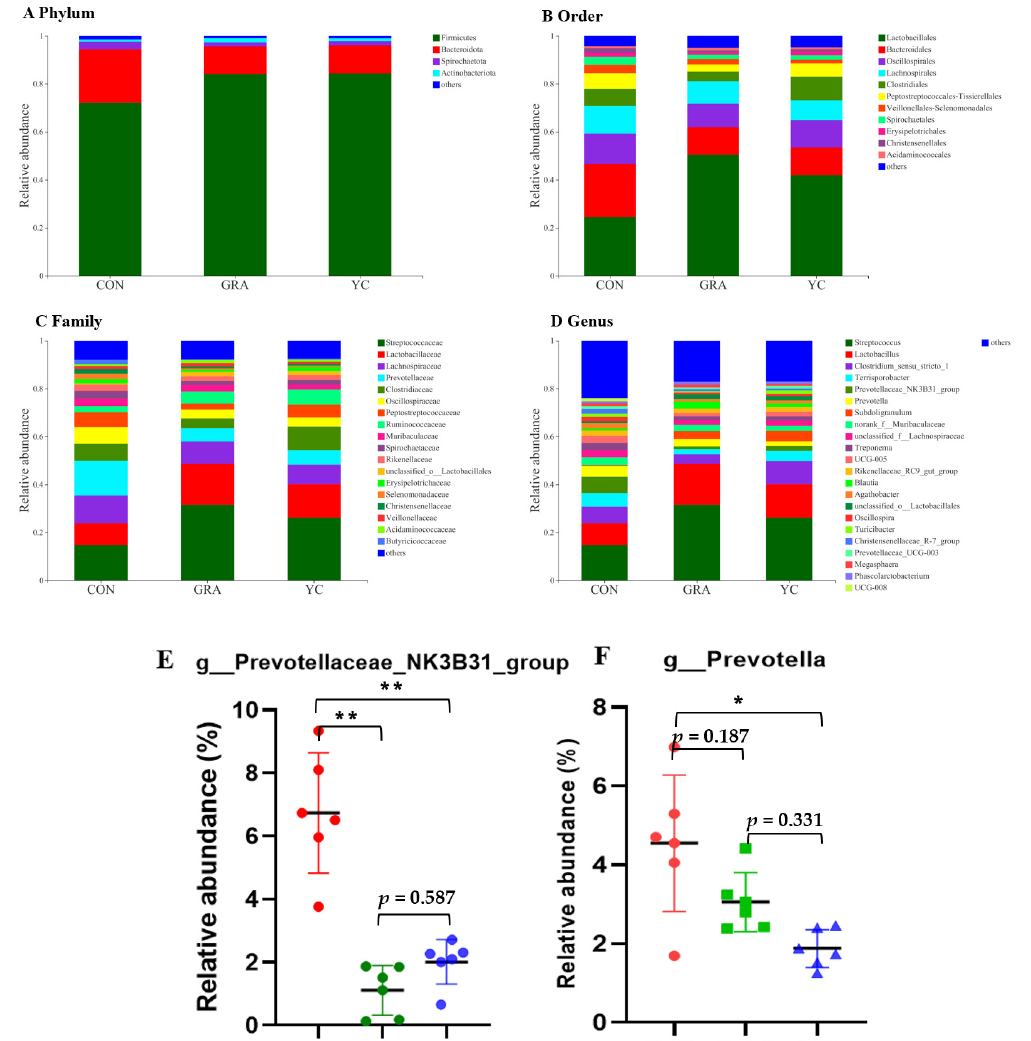
Figure 5. Effects of yeast culture on colon chyme microbial composition. ( A ) The relative amounts of chyme microbiota at the phylum level. ( B ) The relative amounts of chyme microbiota at the order level. ( C ) The relative amounts of chyme microbiota at the family level. ( D – F ) The relative amounts of chyme microbiota at the genus level. Data are expressed as the mean ± SEM. * p < 0.05 and ** p < 0.01.